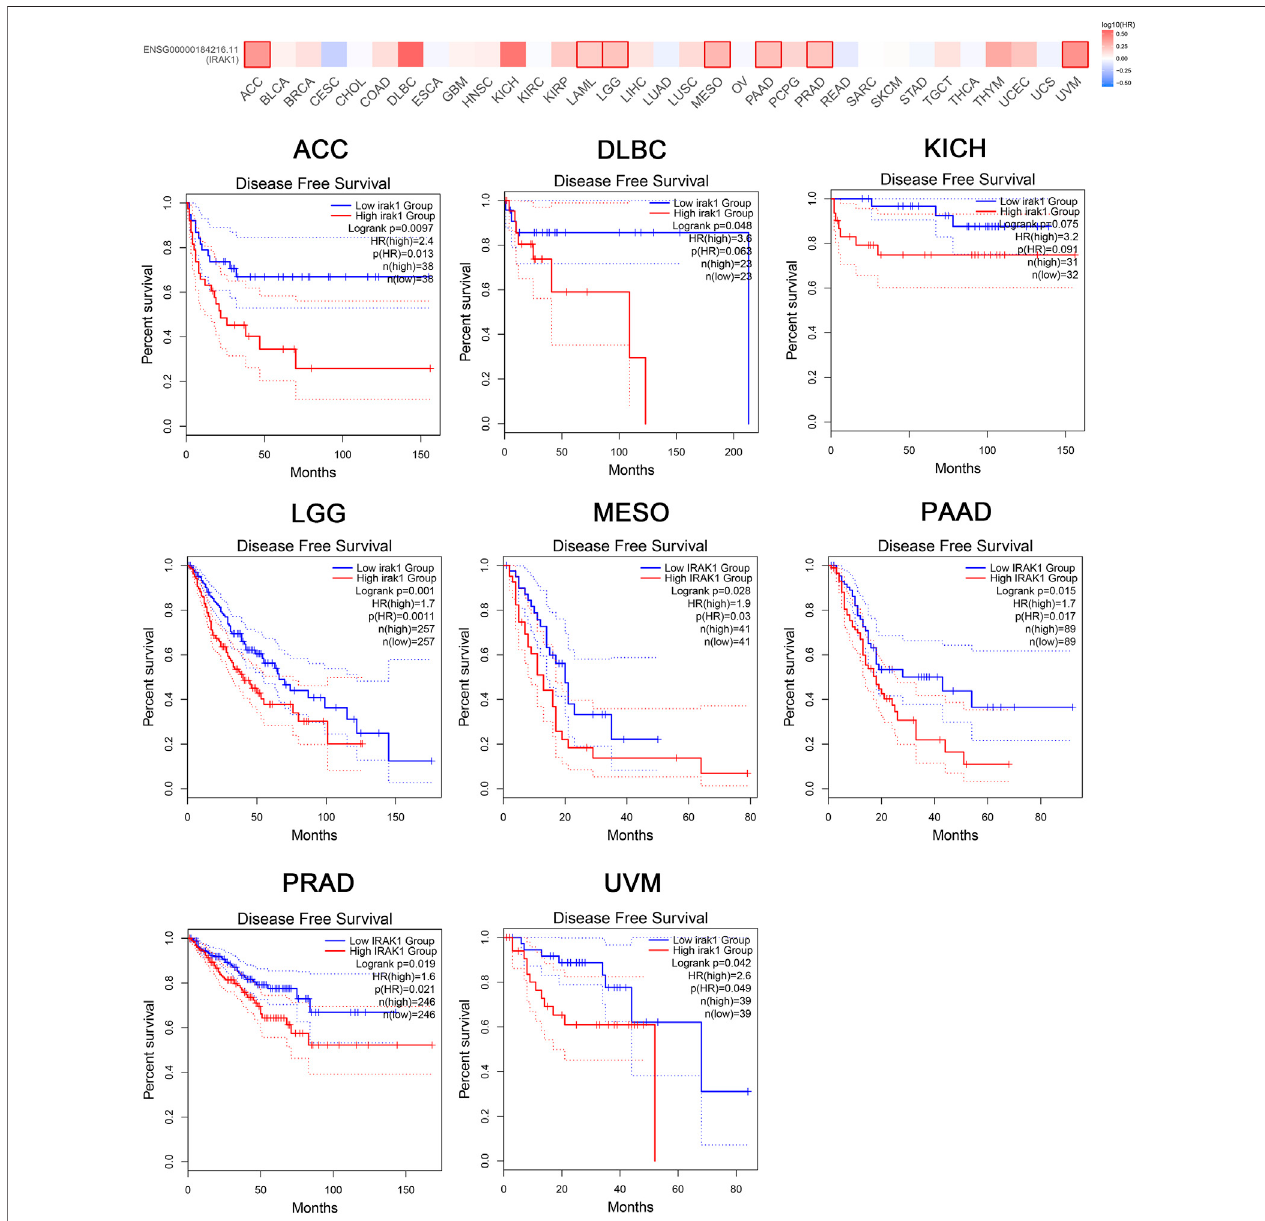
FIGURE 3 | Kaplan-Meier disease-free survival curve of pan-cancers with high and low expression of IRAK1. Correlations between IRAK1 gene expression and disease-free survival from TCGA database are showed. The GEPIA2 tool was used to show the survival map and perform the survival curves.